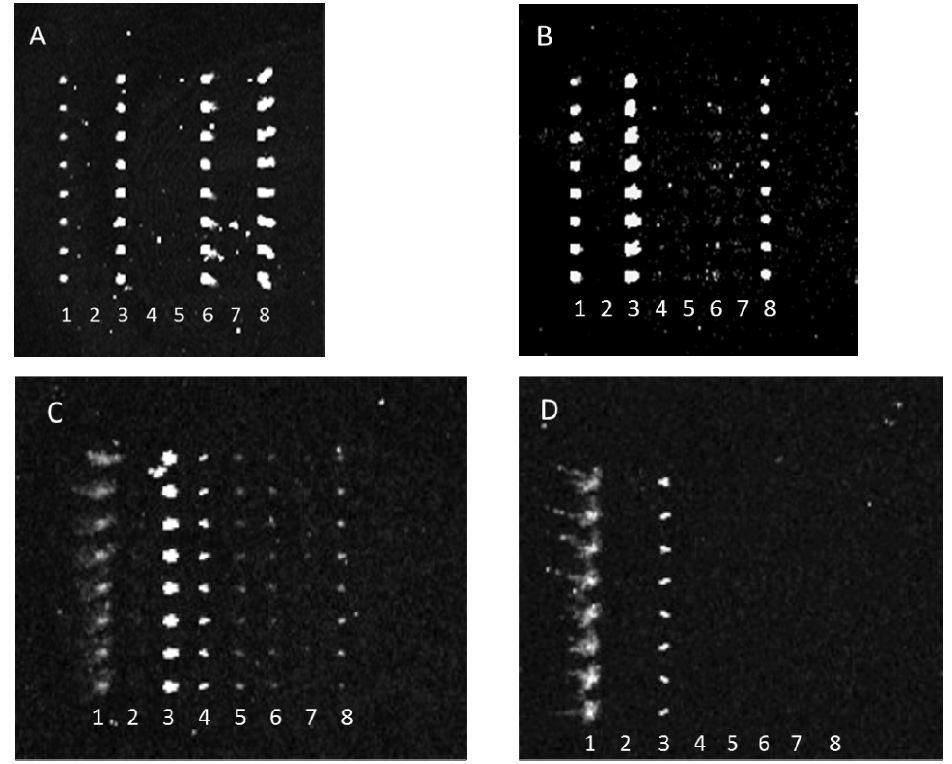
Figure 2. Laser-induced fluorescence scan images of anti-STEC microarrays: Dilution of capture antibody increased specificity to bacterial target in typing microarray. Multiple anti-bacterial capture antibodies were array-printed onto the bottoms of single wells of 96-well microtiter plates. Each column (or lane) within the array was printed with the same antibody, providing 8 replicates. The array was printed as follows: column 1, AF555-labeled antibody marker; columns 2-8, anti-O157, anti-O145, anti-O126, anti-O111, anti-O103, anti-O45, and anti-O26 antibodies, respectively. Samples containing purified bacteria were added to separate, individual wells. After any binding of the bacteria to capture antibody, captured bacteria were visualized via exposure to SYBR Gold and detection with laser-induced fluorescence scanning. Each image, A-D, depicts a single array and reveals the reaction of ca. 1 × 10 8 CFU/mL of: E. coli O26 with PSU anti-STEC IgGs at low (1:10; A) and high (1:500; B) dilutions, and E. coli O145 reacted with KPL anti-STEC IgGs at low (1:30; C) and high (1:100; D)